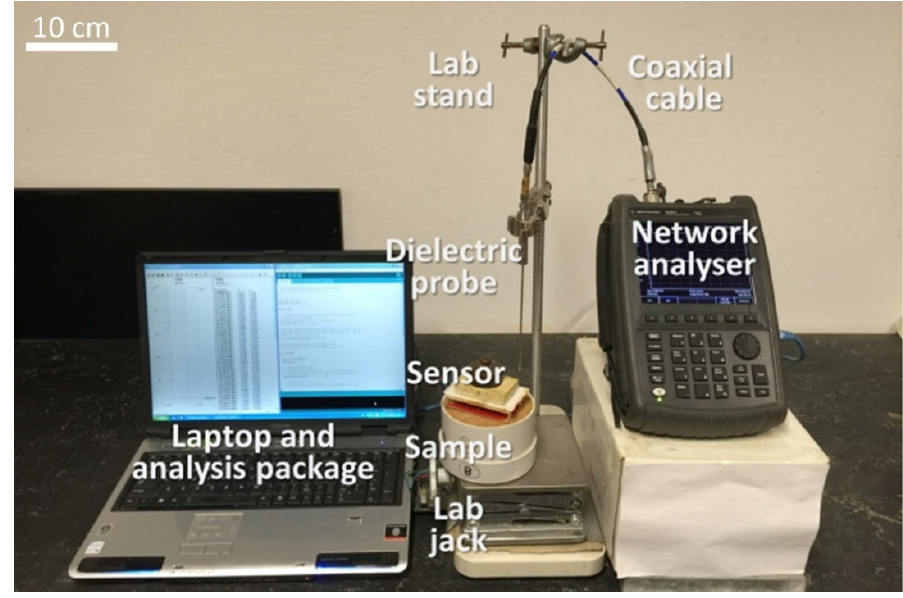
Figure 2. Typical experimental setup.